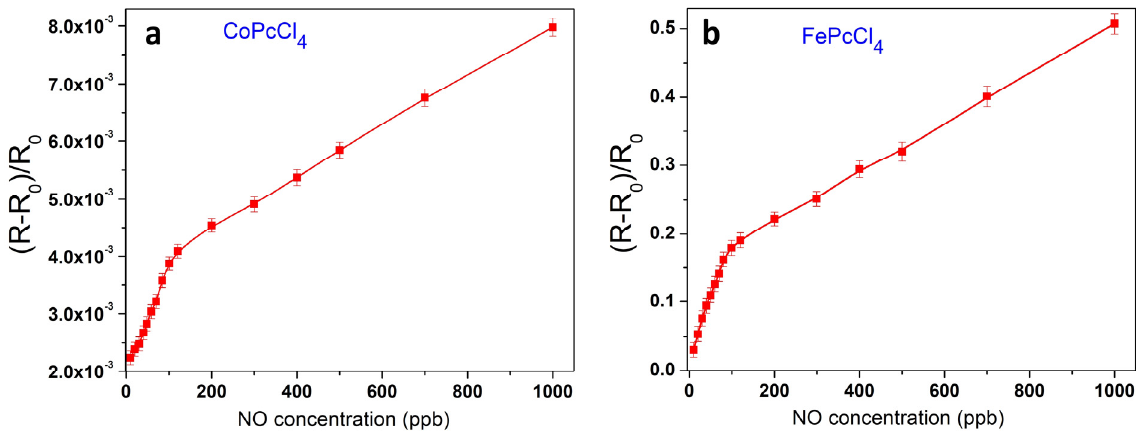
Figure 9. Dependence of the sensor response of CoPcCl 4 ( a ) and FePcCl 4 ( b ) films on NO concentration (10–1000 ppb).